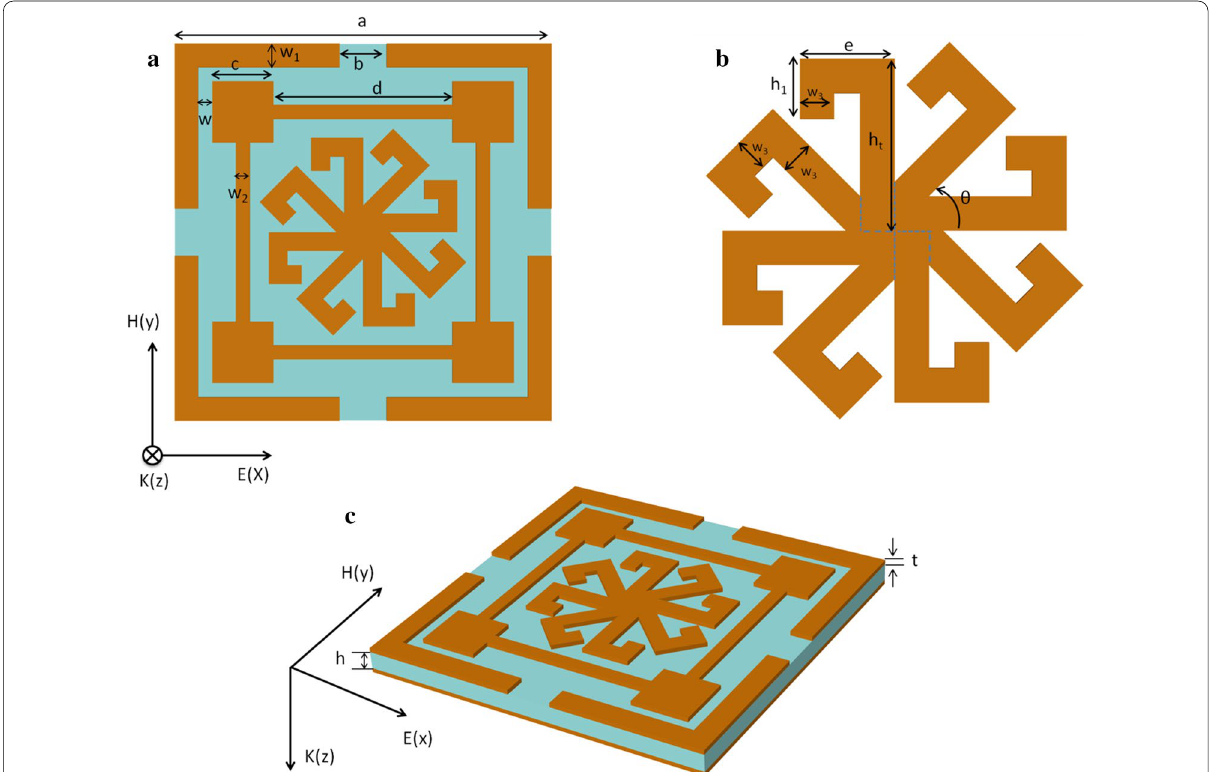
Fig. 1 Schematic geometry of a unit cell for the proposed MA. a Top view, b layout of the eight 7-shaped resonance structures, and c perspective view of a unit